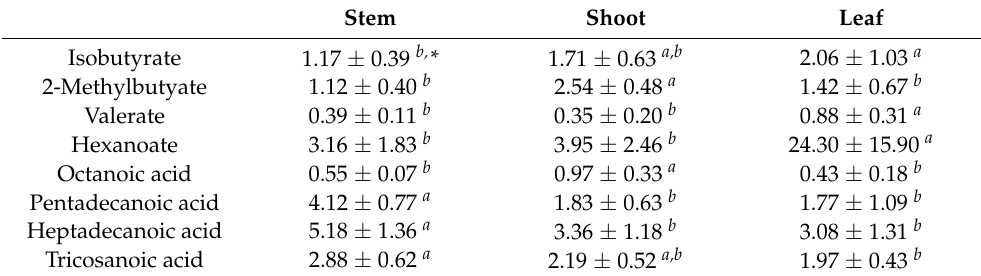
Table 1. Concentrations (mean ± SD, mmol/g) of the fatty acids quantified in absolute terms, which showed significant differences among the bamboo parts observed. Stem Shoot Leaf Isobutyrate 1.17 ± 0.39 b, * 1.71 ± 0.63 a,b 2.06 ± 1.03 a 2-Methylbutyate 1.12 ± 0.40 b 2.54 ± 0.48 a 1.42 ± 0.67 b Valerate 0.39 ± 0.11 b 0.35 ± 0.20 b 0.88 ± 0.31 a Hexanoate 3.16 ± 1.83 b 3.95 ± 2.46 b 24.30 ± 15.90 a Octanoic acid 0.55 ± 0.07 b 0.97 ± 0.33 a 0.43 ± 0.18 b Pentadecanoic acid 4.12 ± 0.77 a Heptadecanoic